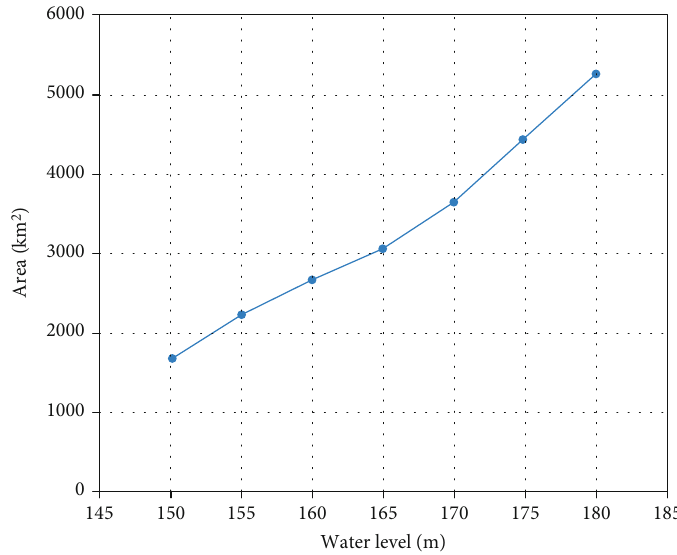
Figure 3: Variation of Lake Nasser surface area versus water level [13].